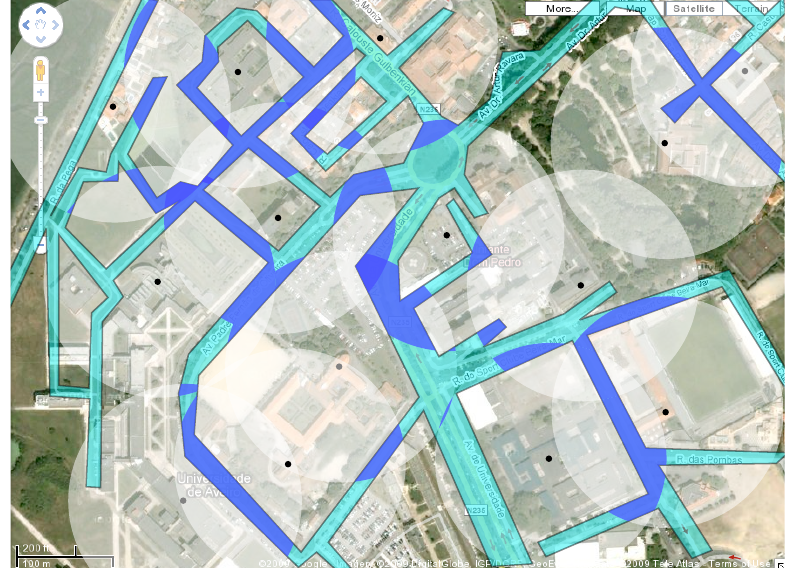
Figure 3. The areas of the polygonal region that are covered by at least two white antennas are shown in dark